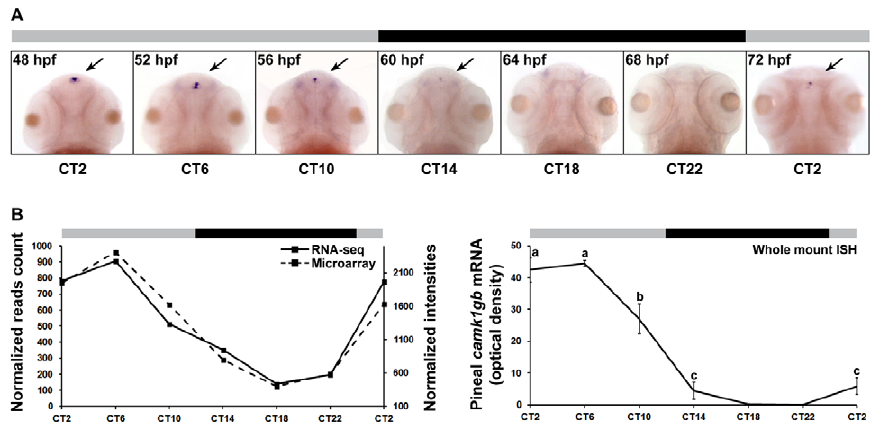
Figure 3. camk1gb spatio-temporal expression. A) Rhythmic expression of camk1gb exclusively in the pineal glands (indicated by black arrows) of 48–72 hpf embryos as detected by whole mount ISH under constant darkness. B) Rhythmic expression of camk1gb in the zebrafish embryo (right) is correlated with the RNA-seq (solid line, left vertical axis) and the microarray data (dashed line, right vertical axis) from the adult (left). Correlation coefficients between the whole mount ISH results and the data obtained by microarrays and RNA-seq were determined by Pearson correlation (r=0.89 and 0.77, respectively). For whole mount ISH, statistical differences in mRNA levels were determined by one-way ANOVA followed by a Tukey test (P-value , 0.05). Error bars represent SE (n=10–15). CT=circadian time. Gray and black bars represent subjective day and subjective night, respectively.